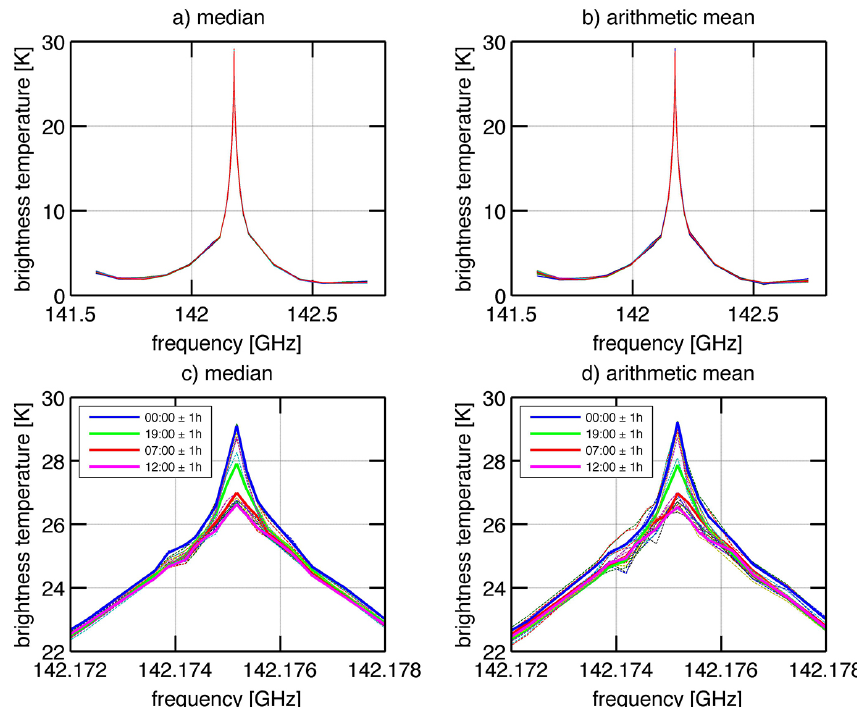
Figure 1. GROMOS spectra for April 2008, averaged with (a) median and (b) arithmetic mean. The averaged time intervals are taken as 00:00, 01:00, 02:00, ... 23:00UT ± 1h, from all days of April 2008, resulting in 24 spectra per month. Different colours correspond to different time bins. A zoom into the line centre is given in (c) for the median calculation and (d) for the arithmetic mean, respectively. Four time bins are highlighted by the thick